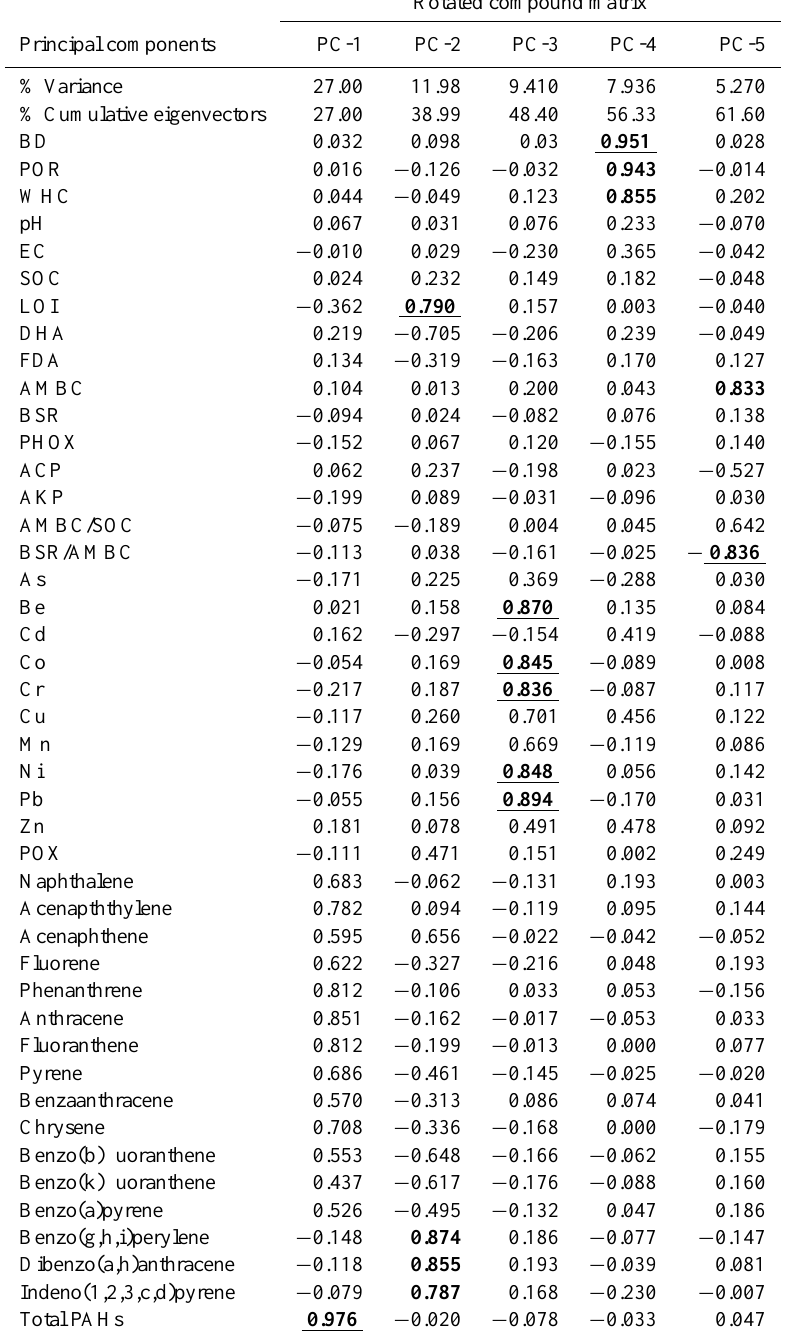
Rotated compound